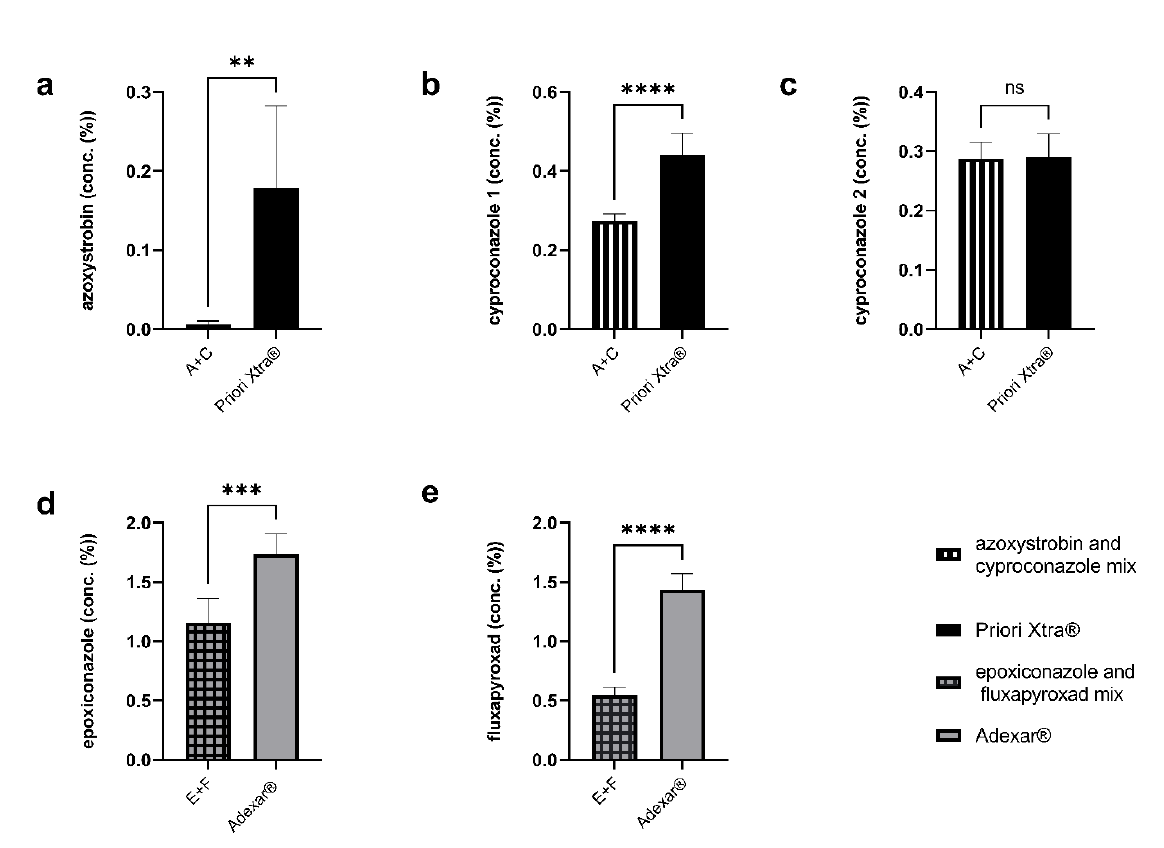
Figure 6: Active substances detected in HepaRG cells after 24 h treatment with Priori Xtra® and its active substances mix ( a, b, c ) and Adexar ® and its active substances mix ( d, e ) and using an LC- MS/MS system. n=3 biological replicates and each sample was injected twice. Significance shown with asterisks: P value ≤ 0.01 are summarized with two asterisks, P values less than 0.001 are summarized with three asterisks, and P values less than 0.0001 are summarized with four asterisks. Ns = not signif-